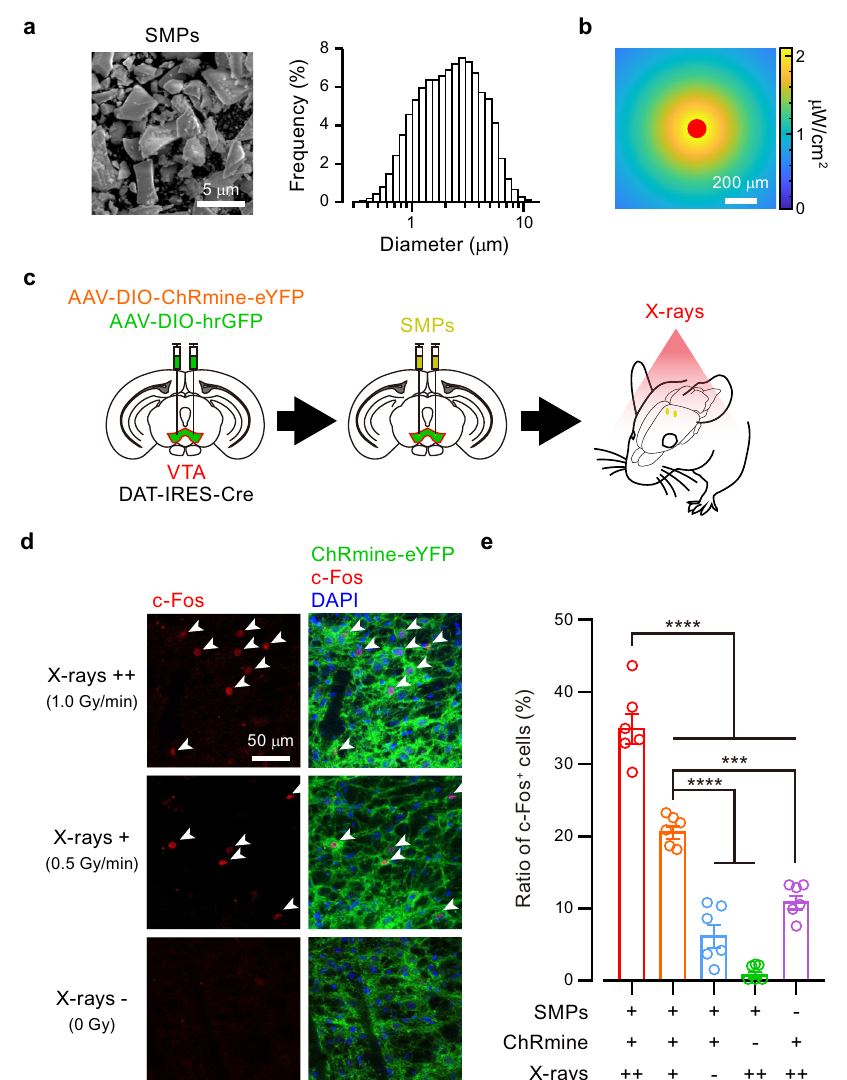
Fig. 3 Radio-luminescence of Ce:GAGG microparticles activated VTA-DA neurons in vivo. a Left, a scanning electron micrograph of SMPs. Right, the size distribution of the SMPs measured by dynamic light scattering. b An RL intensity map around the SMPs (red) injected in the gray matter at a depth of 4.2 mm under 1.0 Gy/min X-irradiation (see also Supplementary Fig. 7). c Schematic of the c-Fos induction experiment. d Representative confocal images showing RL-induced expression of c-Fos (red, arrowheads) among ChRmine-expressing cells near injected SMPs. e Ratio of c-Fos-positive cells under different conditions ( n = 6 hemispheres from 3 mice for each group). SMPs + /ChRmine + /X-rays ++ vs. SMPs + /ChRmine + /X-rays + , **** p < 0.0001; SMPs + /ChRmine + /X-rays ++ vs. SMPs + /ChRmine + /X-rays – , **** p < 0.0001; SMPs + /ChRmine + /X-rays ++ vs. SMPs + /ChRmine – /X-rays ++ , **** p < 0.0001; SMPs + /ChRmine + /X-rays ++ vs. SMPs – /ChRmine + /X-rays ++ , **** p < 0.0001; SMPs + /ChRmine + /X-rays + vs. SMPs + /ChRmine + / X-rays – , **** p < 0.0001; SMPs + /ChRmine + /X-rays + vs. SMPs + /ChRmine – /X-rays ++ , **** p < 0.0001; SMPs + /ChRmine + /X-rays + vs. SMPs –